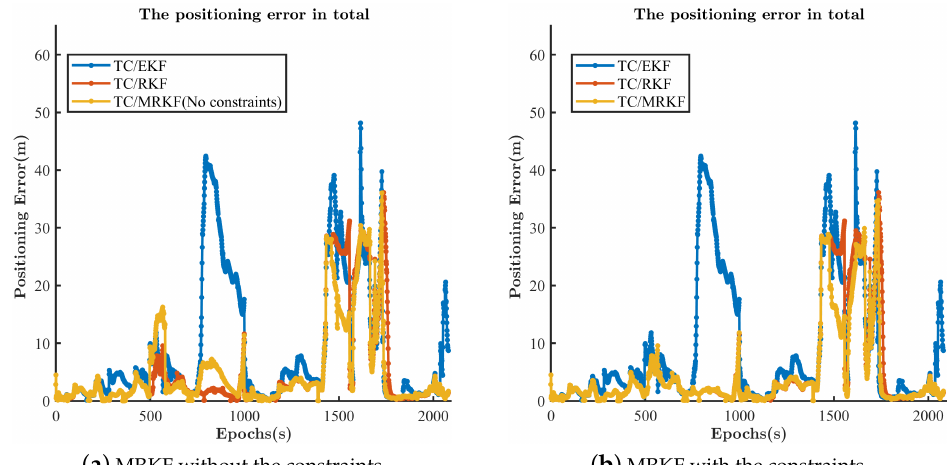
Figure 16. The performances of MRKF with and without the constraints.